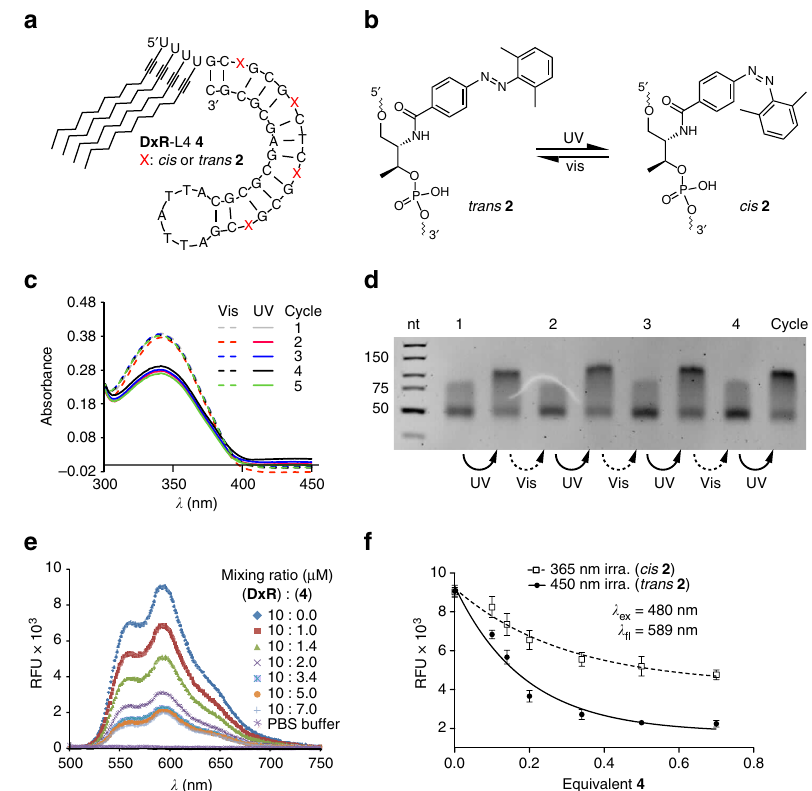
Fig. 3 Switching behavior of the DxR- binding motif. a Schematic of lipid-modi fi ed hairpin-duplex motif with repetitive 5 ′ -CG-3 ′ base pairs for DxR intercalation. The modi fi ed DxR -L4 motif 4 shows the positions of DMAB switches on a D-threoninol backbone marked with a red cross X = 2 ′ ,6 ′ - dimethylazobenzene; and four lipid chains are attached to the 5 ′ -end. b Schematic of the switch mechanism mediated by the DMAB photoswitch. c UV/vis spectrum of DxR -L4 motif 4 in a range between λ = 300 and λ = 420 nm, showing two sets of curves for the reversible photo switching of the DMAB moiety for alternating irradiation with UV (solid lines) and visible light (vis., dotted lines). The absorption maximum lies at λ = 345 nm. d Analytical PAGE analysis of reversible switching 2 ′ ,6 ′ -dimethylazobenzene functionalized DxR -L4 motif 4 . e Fluorescence emission spectra ( λ ex = 480 nm) of a DxR solution with increasing molar ratios of 4 in the range of 1 – 7 µ M (0.1 – 0.7 equiv.) showing a reduction in fl uorescence intensity of DxR with an increasing concentration of added motif 4 . f Comparison of fl uorescence quenching of DxR with the DMAB moiety in trans- (black circles) and in cis- (white squares) conformation ( n = 3, error bars: mean ±